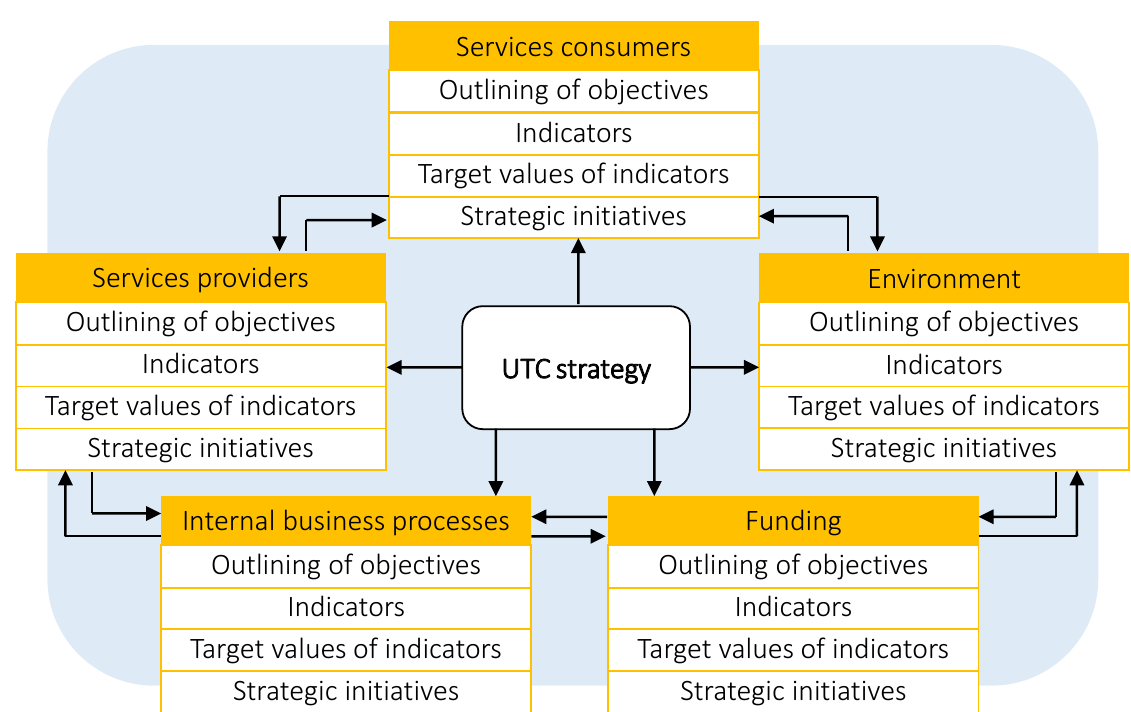
Figure 3. Information component of BSC